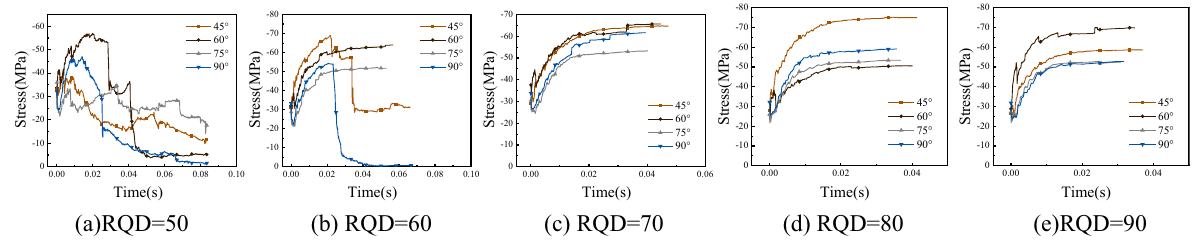
Fig. 19 Tangential stress with different inclined angles of joints in the same RQD ( σ